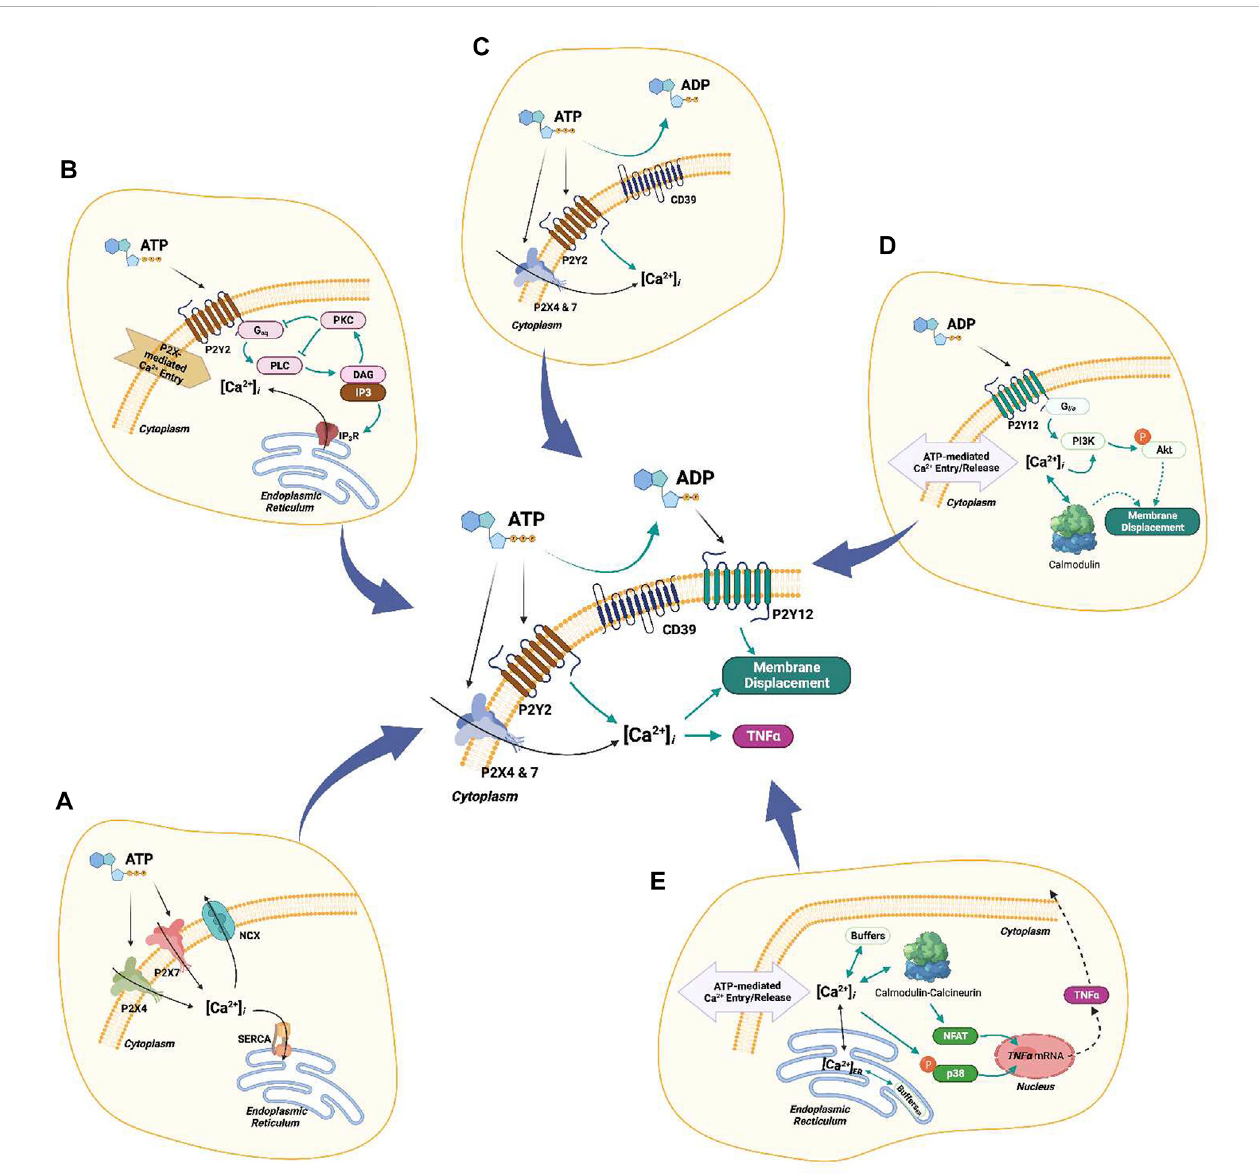
FIGURE 9 Complete schematic of the computational model. (A) P 2 X 4/7-mediated Ca 2+ entry. (B) P 2 Y 2-mediated Ca 2+ transients. (C) Hydrolysis of ATP by ENTs (CD39). (D) P 2 Y 12-mediated cell migration. (E) Ca 2+ -dependent downstream cascades associated with TNF α